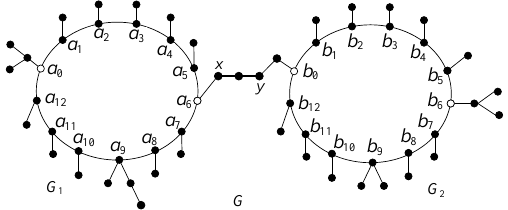
Figure 3. A double-cyclic graph, where G 1 and G 2 are odd- ( 13,6 )